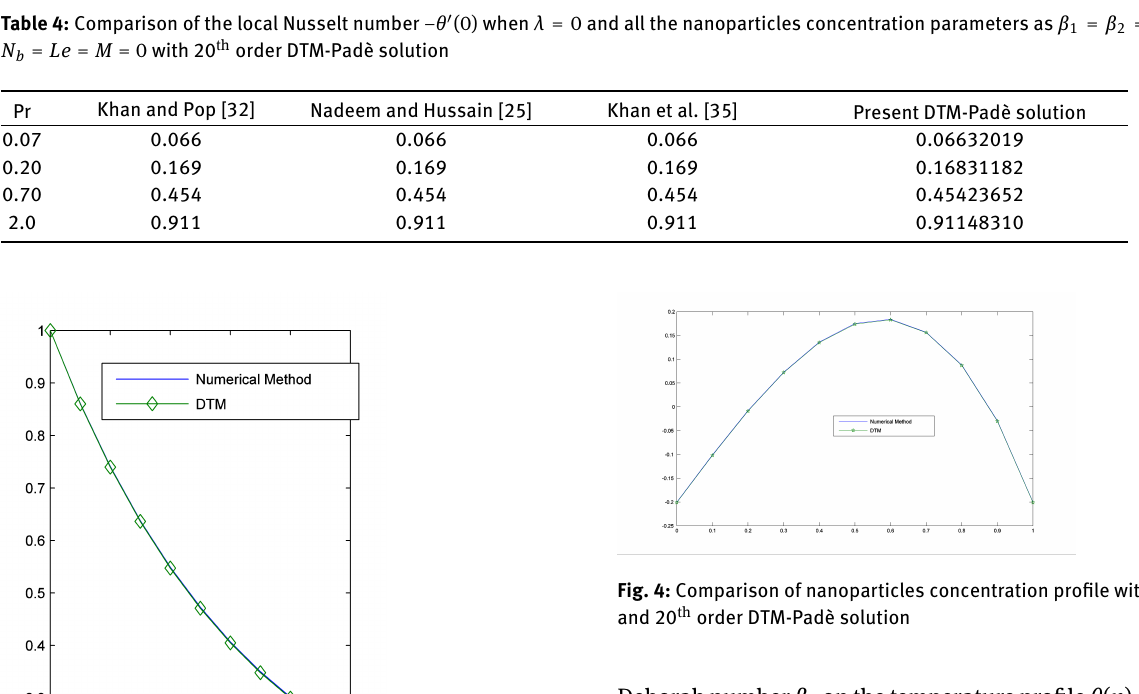
Deborah number β on the temperature profile θ ( η ). An in- 1 creases of Deborah number both the fluid temperature and thermal boundary layer thickness increases. This is due to the fact that the Deborah number involves relaxation time λ leads to enhancement in thermal boundary layer 1 thickness and temperature. While β depends on the retar- 2 dation time λ . Larger retardation time leads to a weaker 2 temperature profile shows in Fig. 8. Fig. 9 depicts the